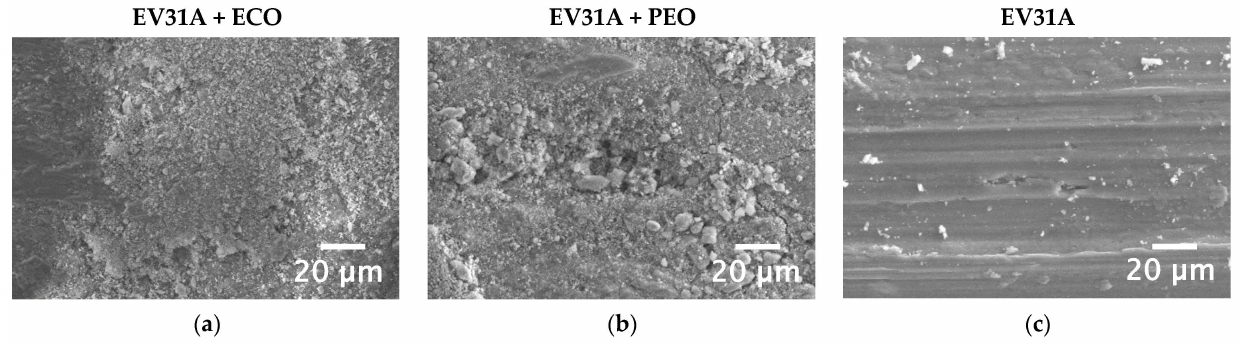
Figure 10. Dry sliding tests (vs. 100Cr6 steel, 5 N, 1000 m, 0.3 m/s): SEM micrographs of wear scars comparing ECO ( a ) and PEO-treated ( b ) samples with untreated EV31A-T6 ( c